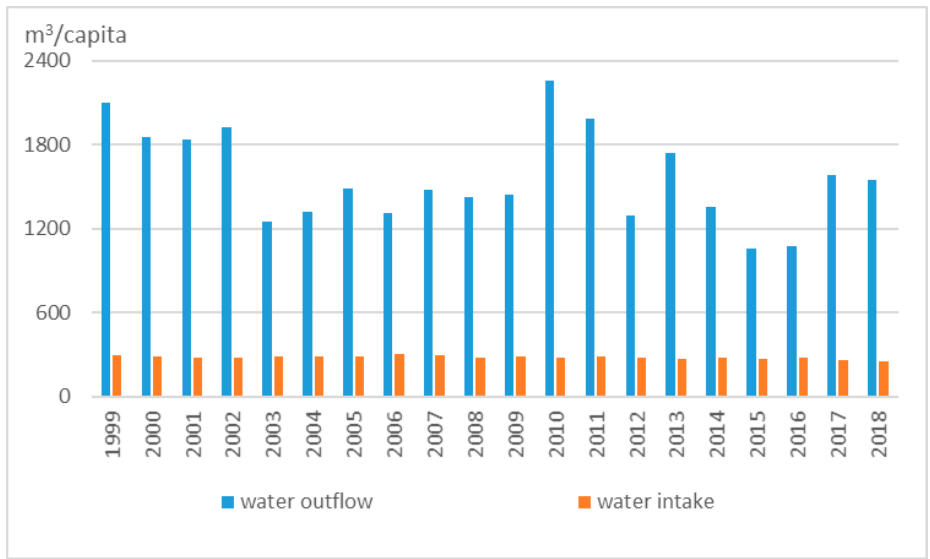
3 / cap in the period 1999–2018 (based on [26]).